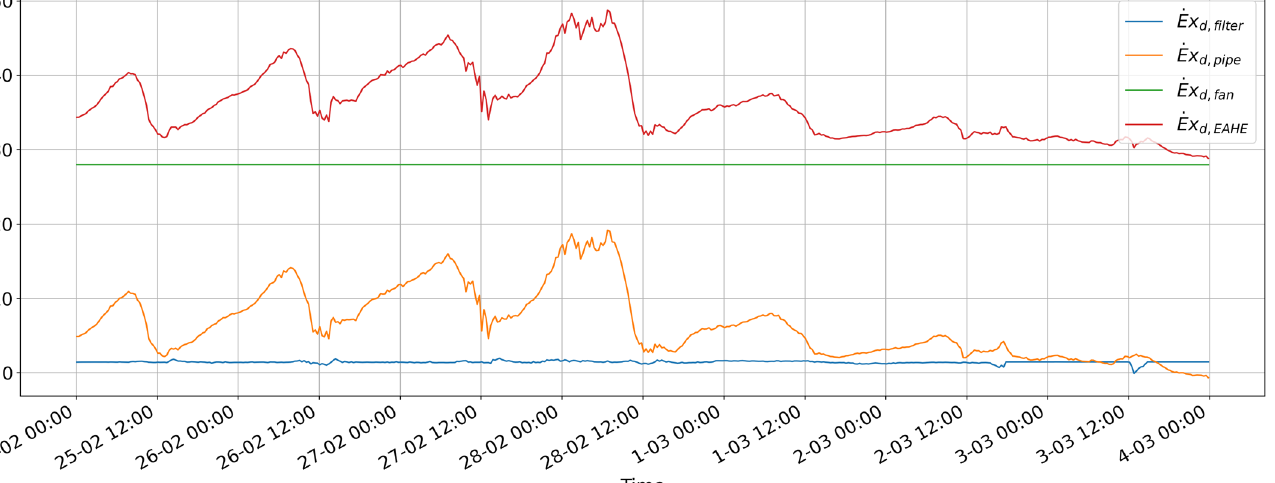
Figure 5. Exergy rates transferred to or from the system during the analysis period.